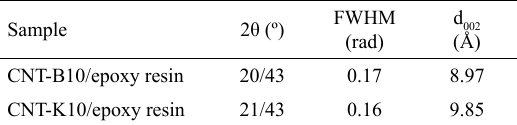
, d ) of nanostructured 1/2 002